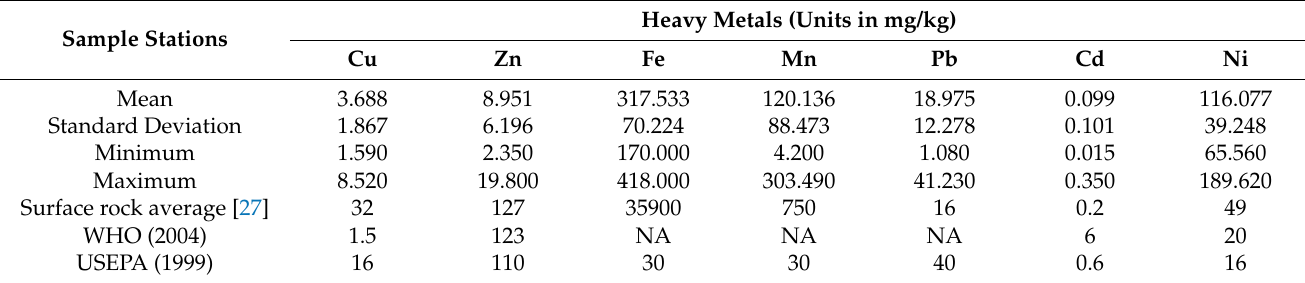
Table 1. Heavy metal concentration in the bottom sediment of Surma River with descriptive statistics.